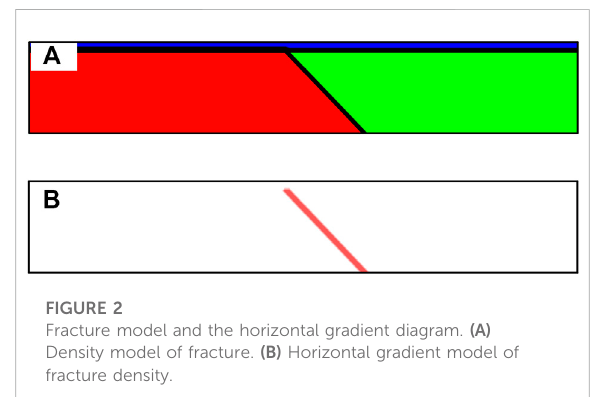
FIGURE 1 One-to-one correspondence between the model element grid and measuring point grid.